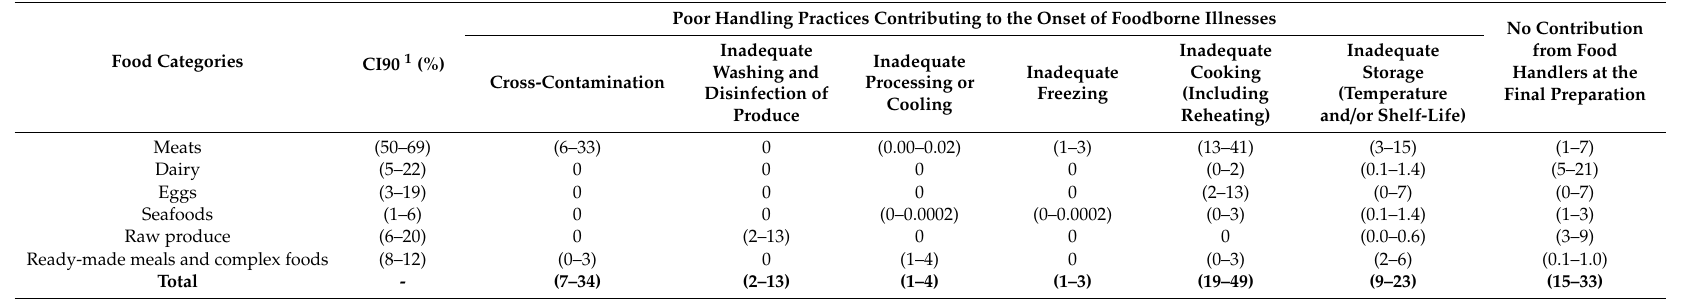
Figure 1. Sankey diagram of the foodborne disease burden according to the different food categories and the consumers practices (detailed percentages are given in Table 5). Table 5. Attribution of foodborne disease burden (FBDB) to food-handling